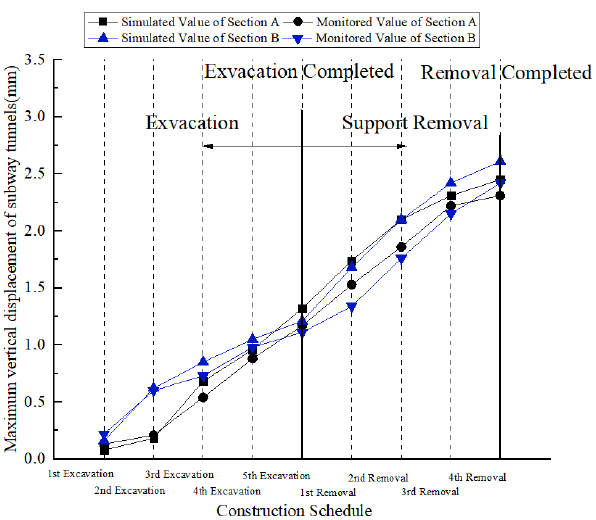
Figure 10. Maximum vertical deformation of subway tunnel caused by foundation pit